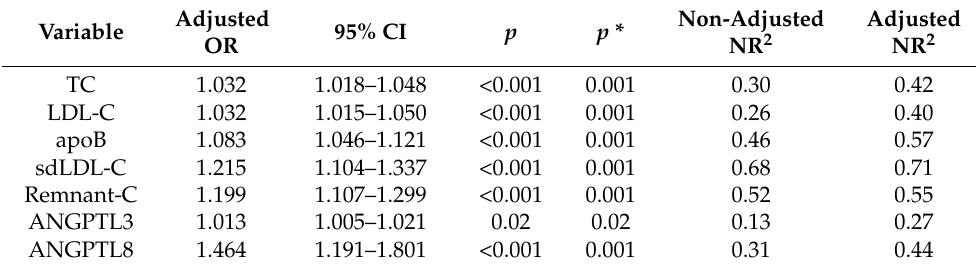
Table 3. Multivariable logistic regression analysis for predictors of TG > 100 mg/dL (>1.13 mmol/L) in the study